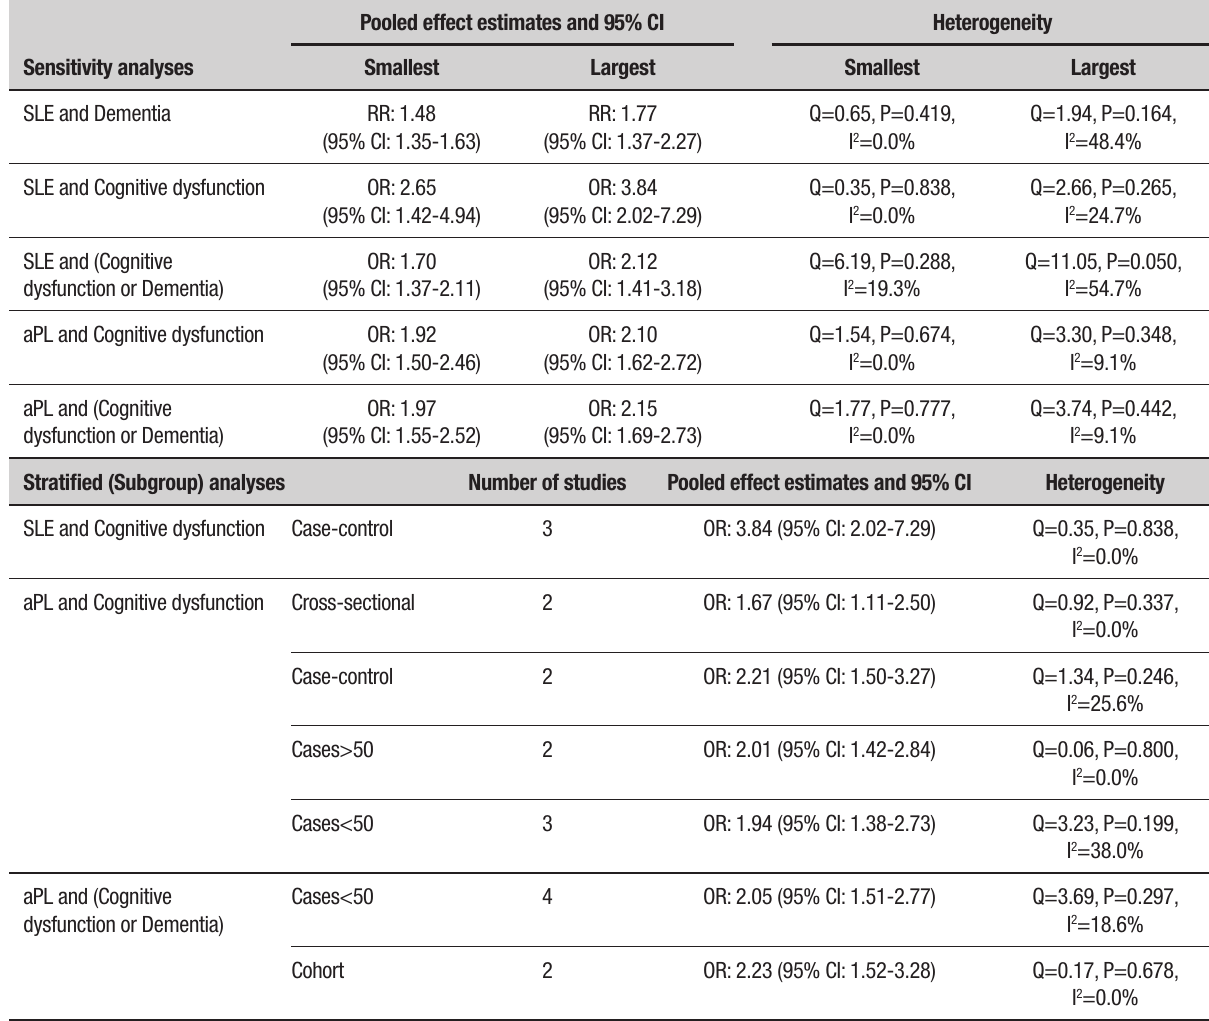
Table 3. Sensitivity and Stratified (Subgroup) analyses for the associations between (SLE or aPL) and (Cognitive dysfunction or